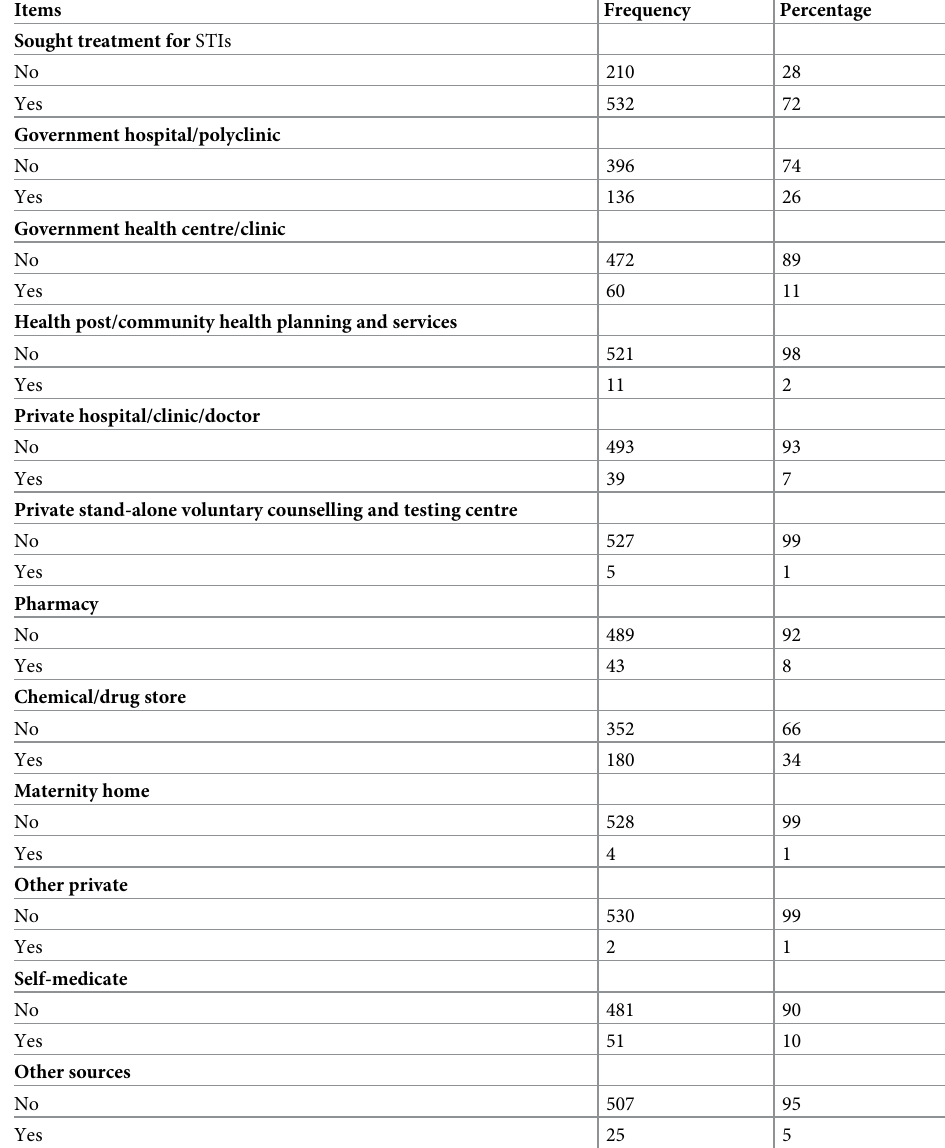
Table 2. Health-seeking behaviours of young women with STIs (n = 742).